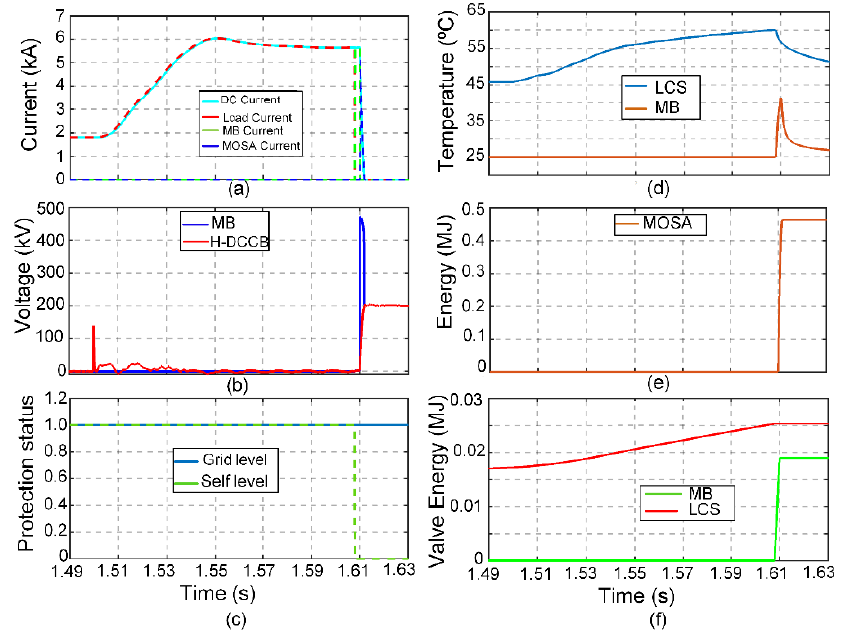
Figure 10. High impedance fault interruption under self-level protection, a) current b) voltage, c) protection status, d) valve temperature, e) MOSA energy, f) valve energy.